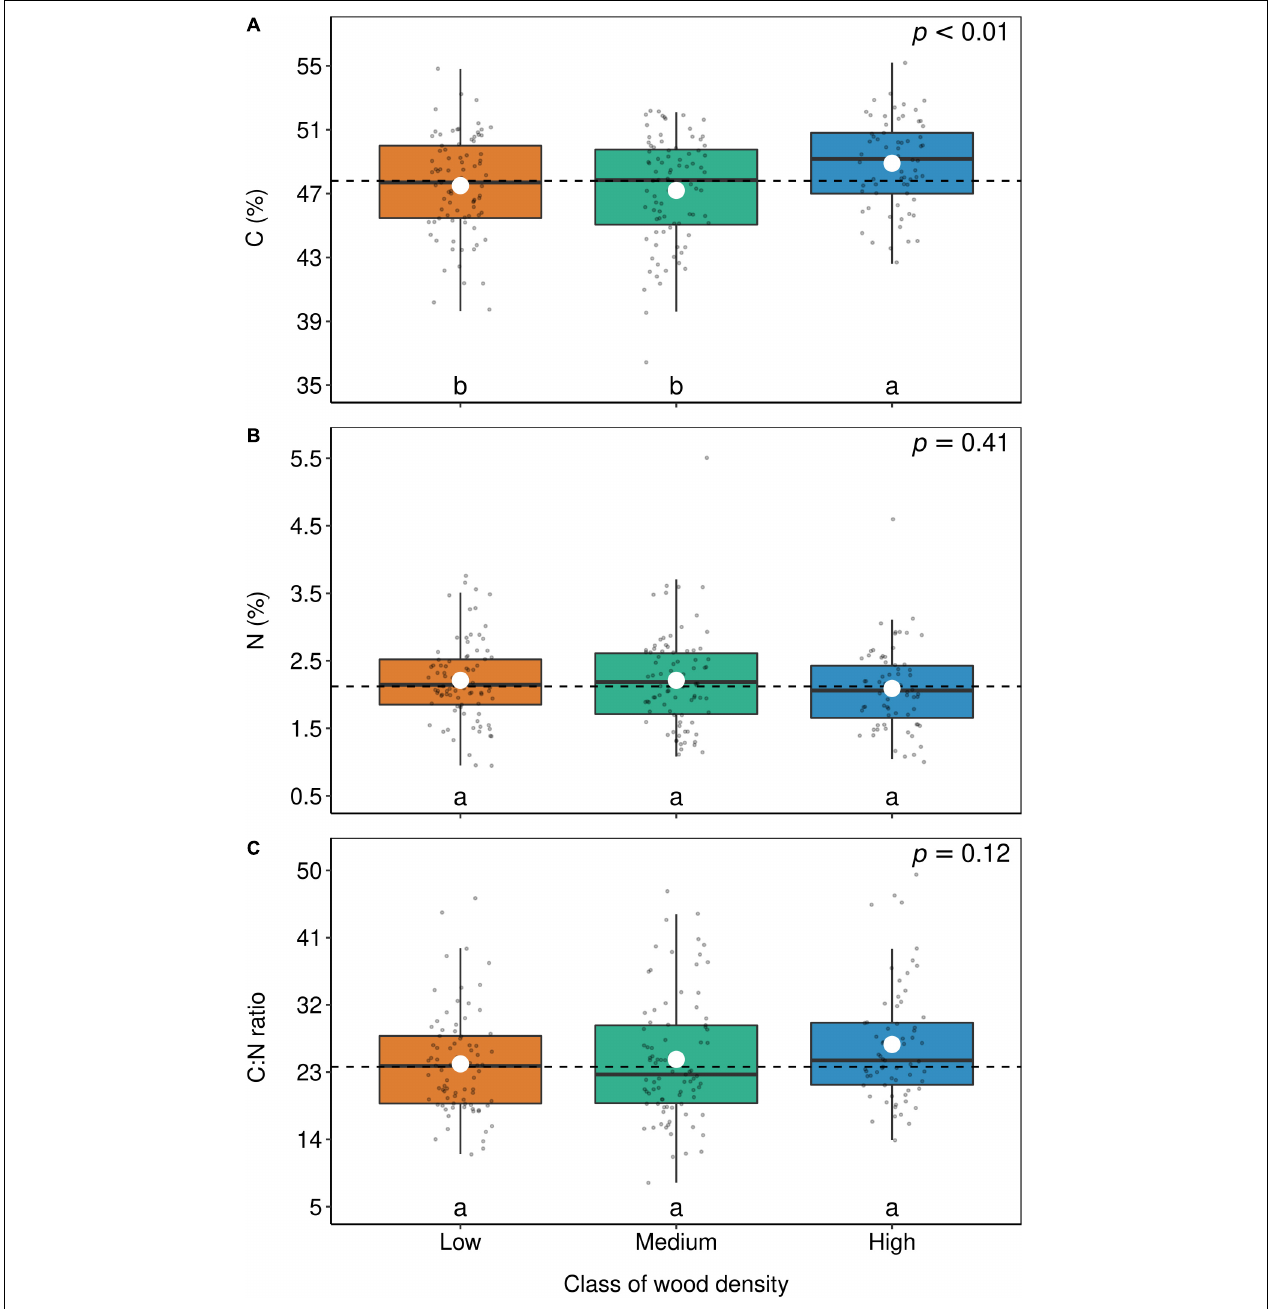
FIGURE 8 | Box-plots of foliar C (A) , N (B) , and C:N ratio (C) according to wood density groups. Each dot represents the mean of a botanical genus. The horizontal lines inside each box represent the median; the box represents the first and third quartiles; and the bars represent the interquartile range. The horizontal dashed line represents the mean of the entire population. White circles represent estimate means obtained from the linear model. The summary of the statistical model can be seen in Supplementary Table 3 . Levels followed by a common letter are not different according to the Sidak-test at p ≤